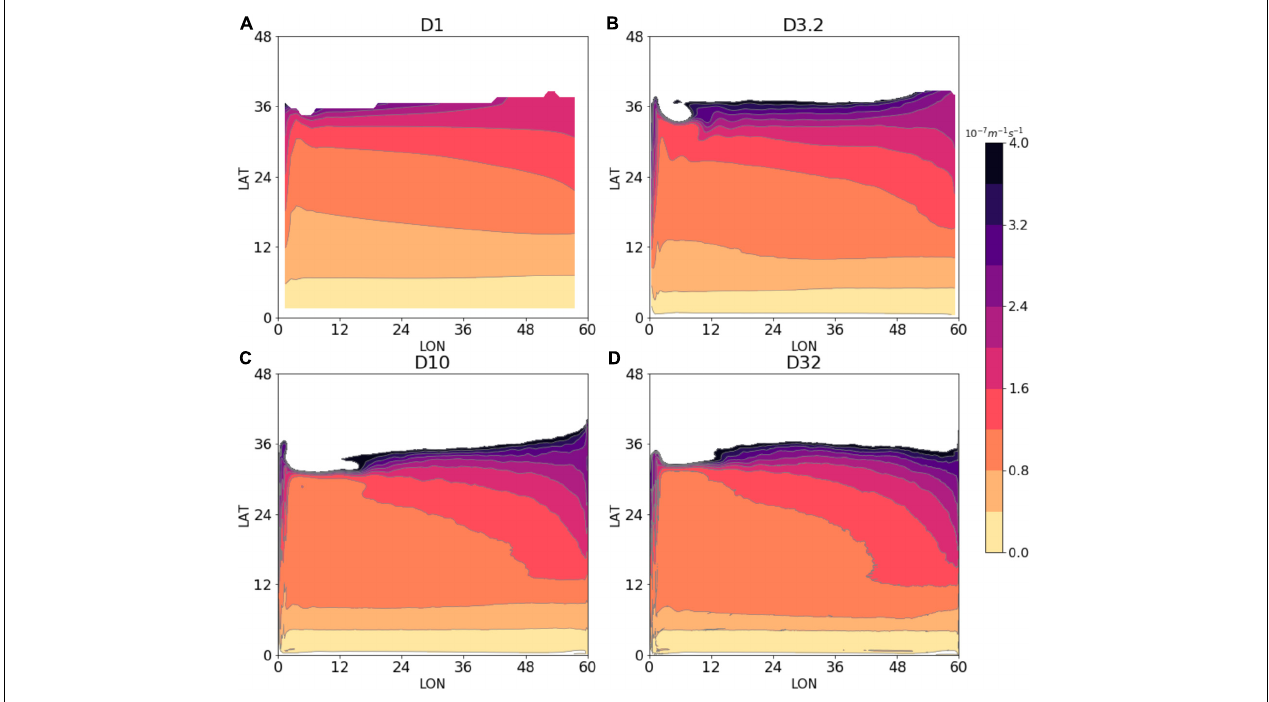
FIGURE 8 | Time-averaged columnar PV (in 10 − 7 m − 1 s − 1 ) calculated from the thermocline depth. Note that the white part represents the region north of where the main thermocline outcrops. (A–D) Correspond to experiments D1, D3.2, D10, and D32,